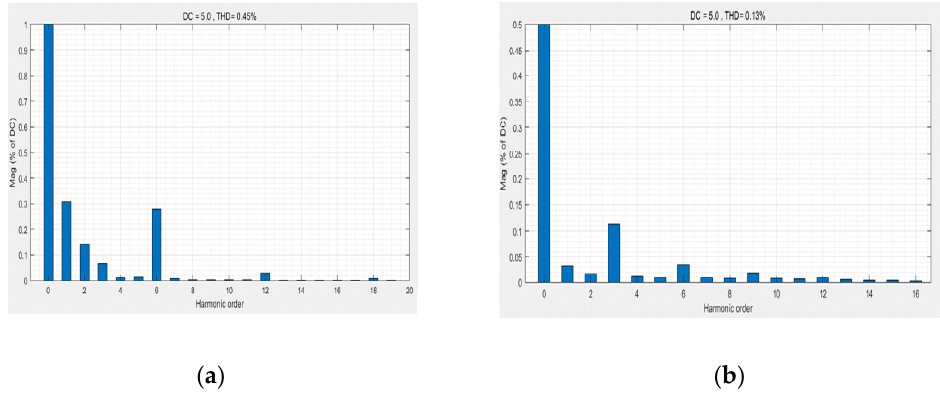
Figure 10. Fast Fourier Transform analysis of reactive component control structures: ( a ) controlled by backstepping control method; ( b ) controlled by SMVS. by backstepping control method; ( b ) controlled by